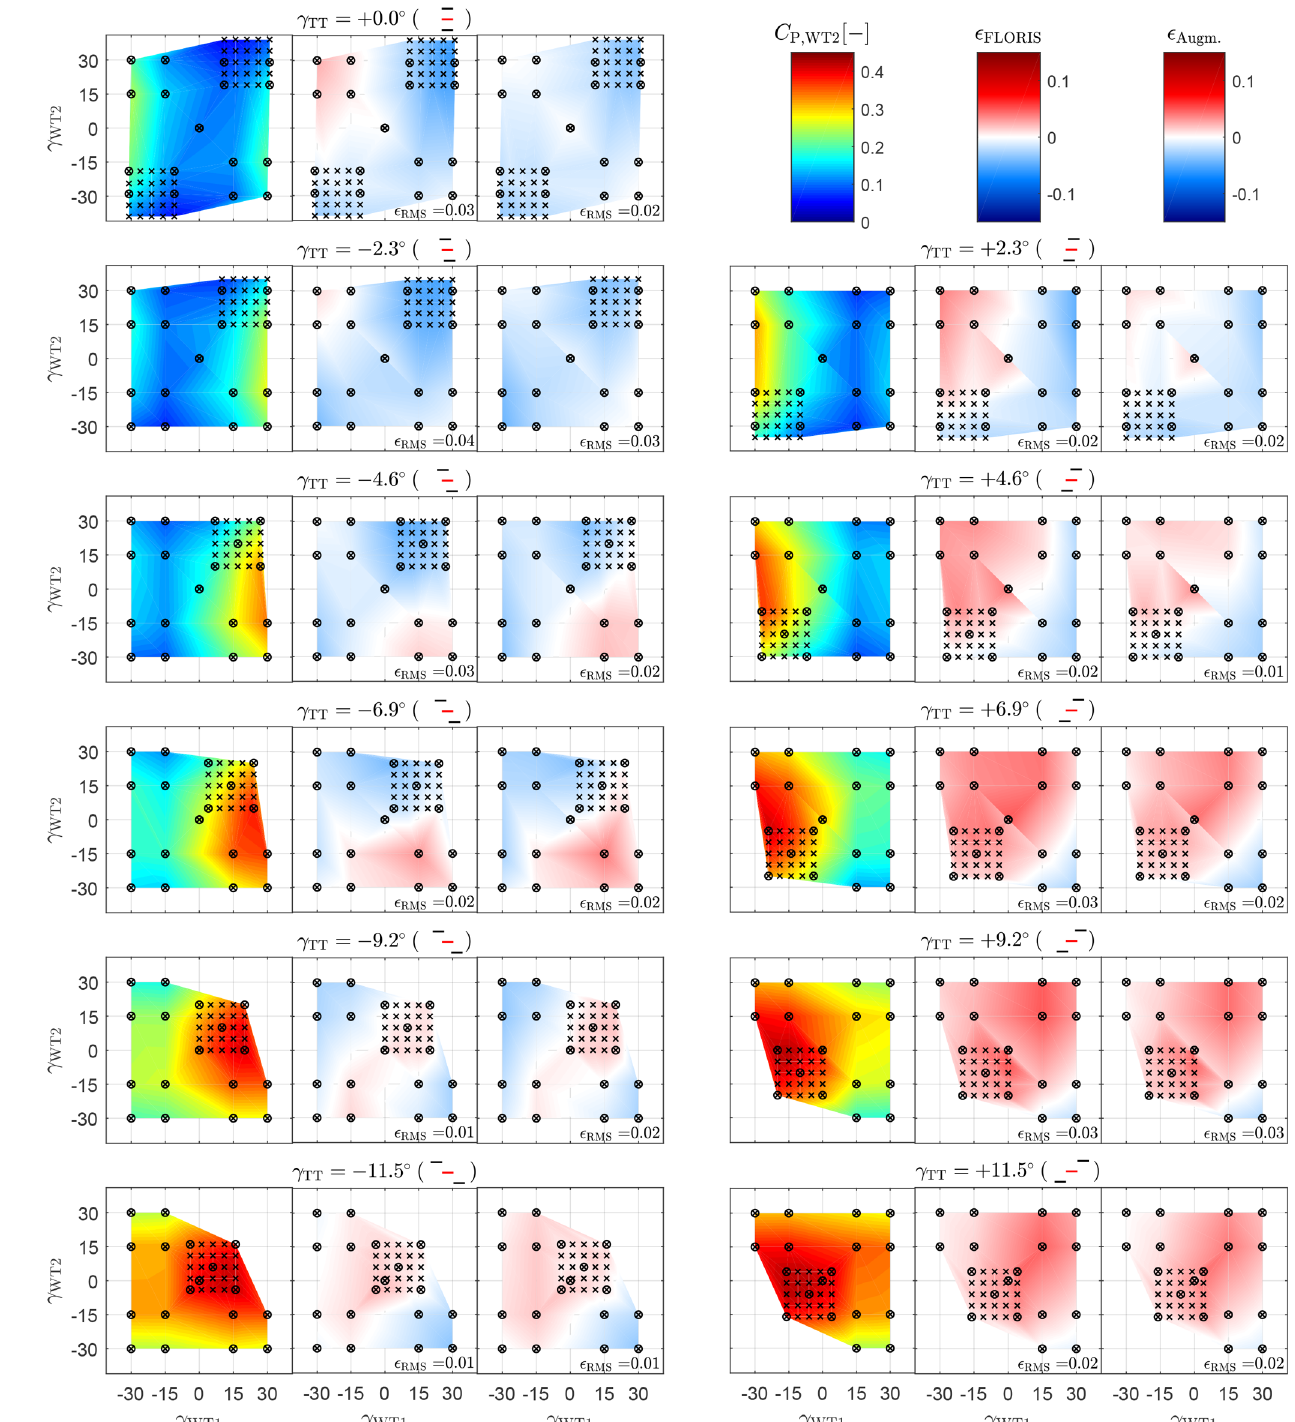
Figure A2. Wind turbine WT2. Each cluster of three subplots represents a unique turntable position, as indicated by the title and the wind farm layout sketch. Left subplot: turbine power coefficient C P , WT2 as a function of γ WT1 ( x axis) and γ WT2 ( y axis). Middle subplot: FLORIS model error. Right subplot: augmented model error. Cross symbols: all measured configurations. Circles: conditions used for parameter